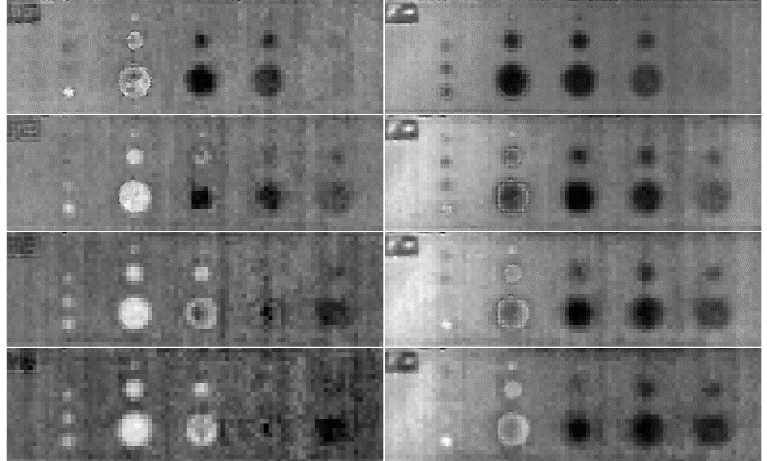
Figure 5. Defect phase contrast obtained by processing every 3rd, 6th, 9th and 12th frame (top down): Procedure A left, Procedure B right.